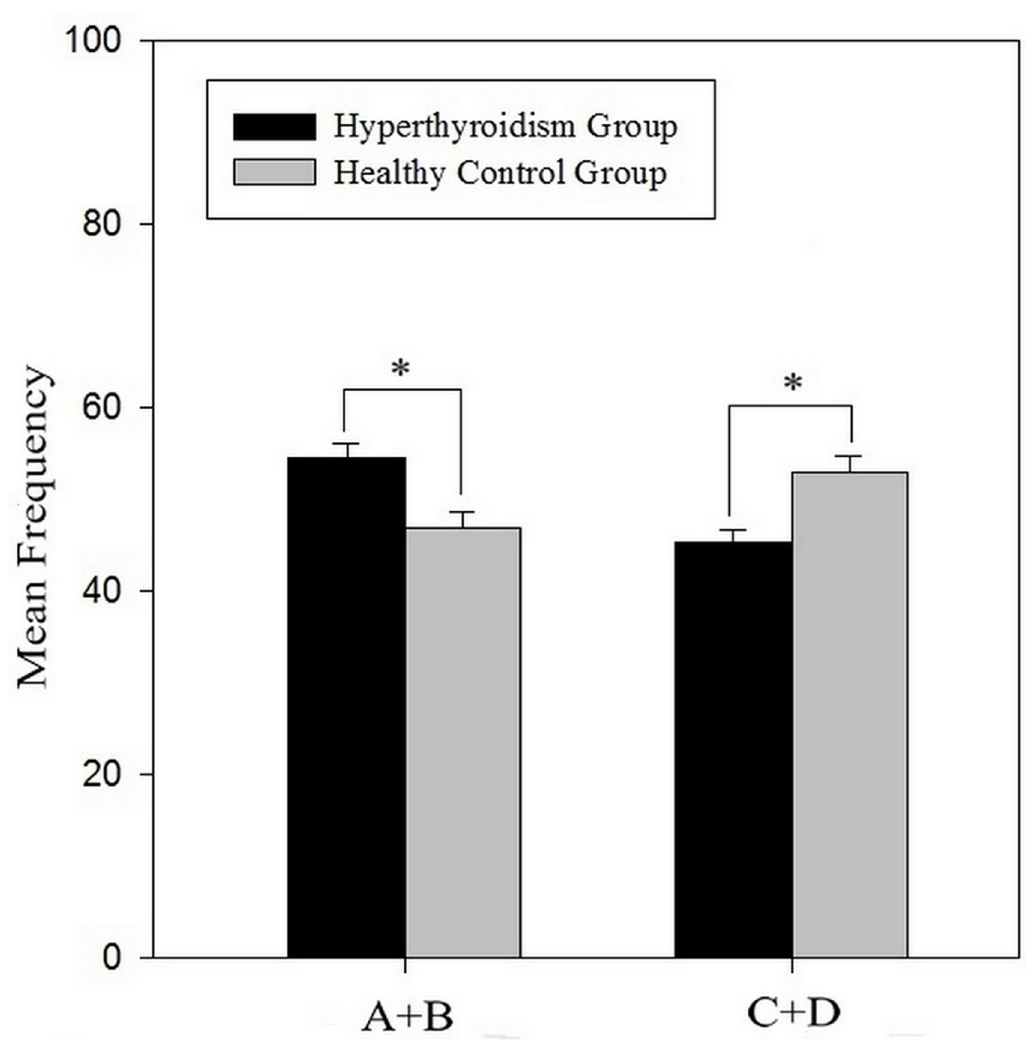
Fig 1. The mean frequency of advantageous choices (A+B) and mean frequency of disadvantageous choices (C+D) for the hyperthyroidism group and the healthy control group. Error bars indicate standard errors of the mean. Items marked with * : p <